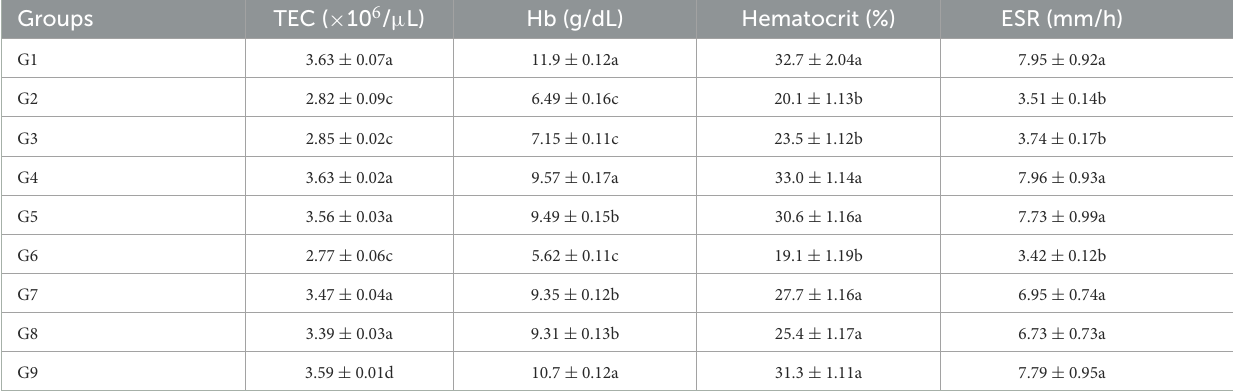
TABLE 3 Hematological parameters including total erythrocyte counts, hemoglobin concentration, hematocrit, and erythrocyte sedimentation rate on day 42 experiment in broiler chicks administered arsenic, chromium, vitamin E, and bentonite alone or in combination.